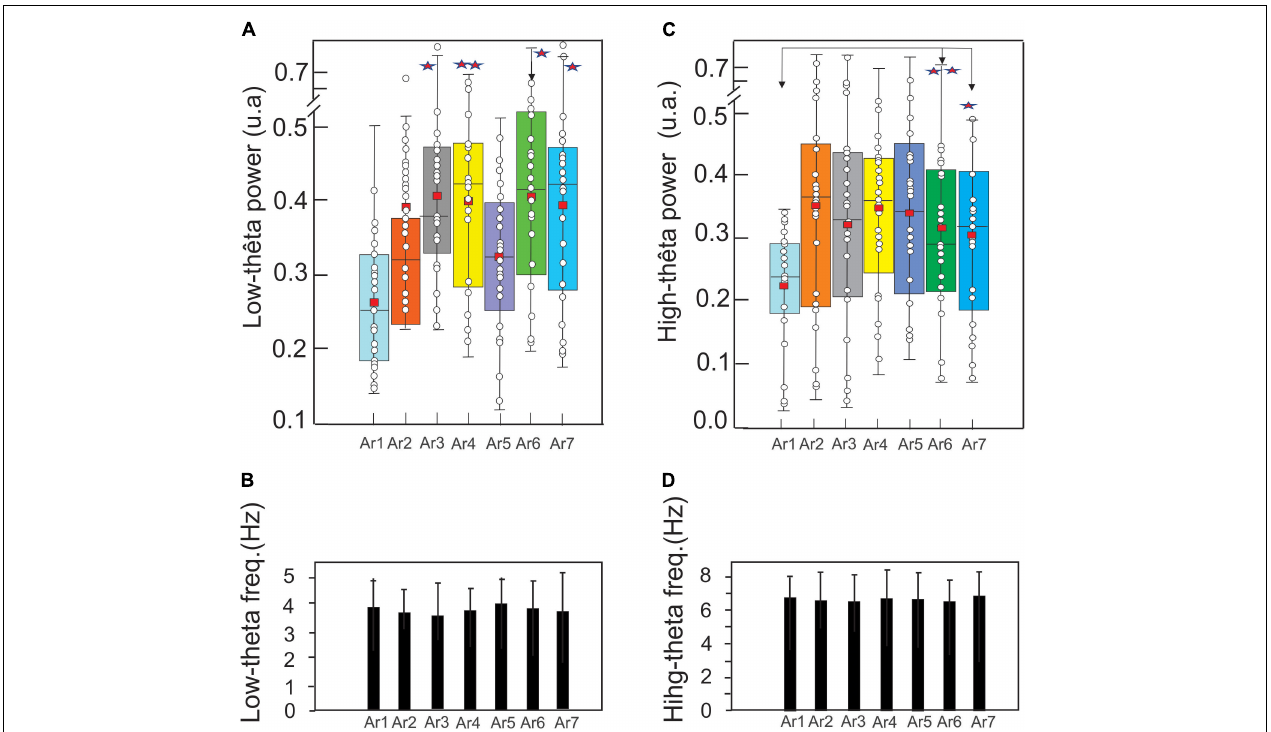
FIGURE 9 | Evolution of the mean ± SD of the low theta (A) and high theta (C) (EC and EO pooled) power in a boxplot configuration and of the respective frequency peaks (B,D) (control before the RB session) to AR7, in the six subjects who showed an increase of these theta oscillations for at least one AR testing (AR2–AR7). The asterisk indicated the level of significance * p < 0.05 and ** p <